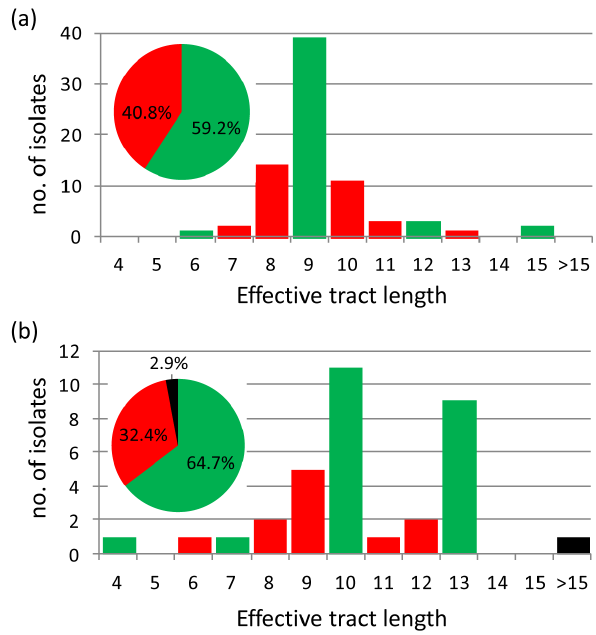
Figure 4. Distribution of effective homopolymeric tract lengths for hmbR and hpuA among a representative panel of English, Welsh and Northern Irish invasive serogroup B meningococcal isolates collected from 2008–2011. Bar charts show the number of isolates with a particular ‘effective homopolymeric tract length’ for hmbR (a) and hpuA (b). Green bars indicate a predicted ON expression state, red bars indicate a predicted OFF expression state, and black bars indicate an indeterminate expression state for a single isolate with a homopolymeric tract length of . 15 G repeats. Inset are pie charts depicting the proportion of isolates representing each expression state for the respective genes.